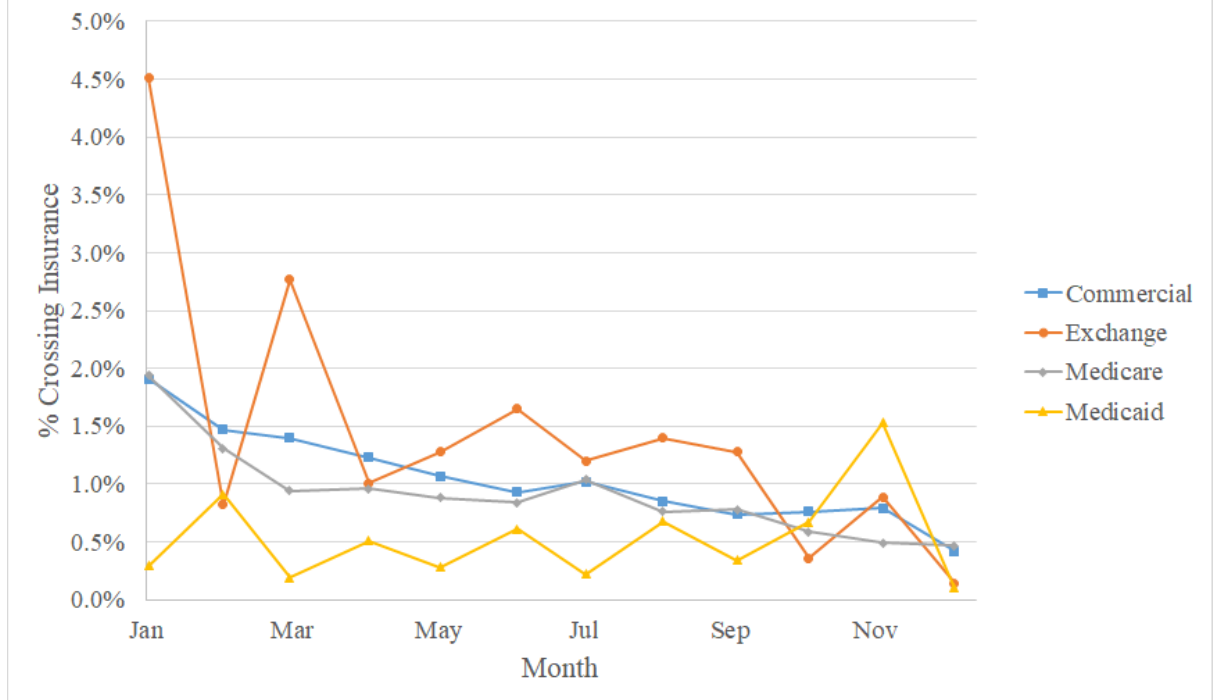
Figure 2 indicates that among Medicaid beneficiaries, crossover alerts occurred less often (60/11,668, 0.5%; P <.001) and did